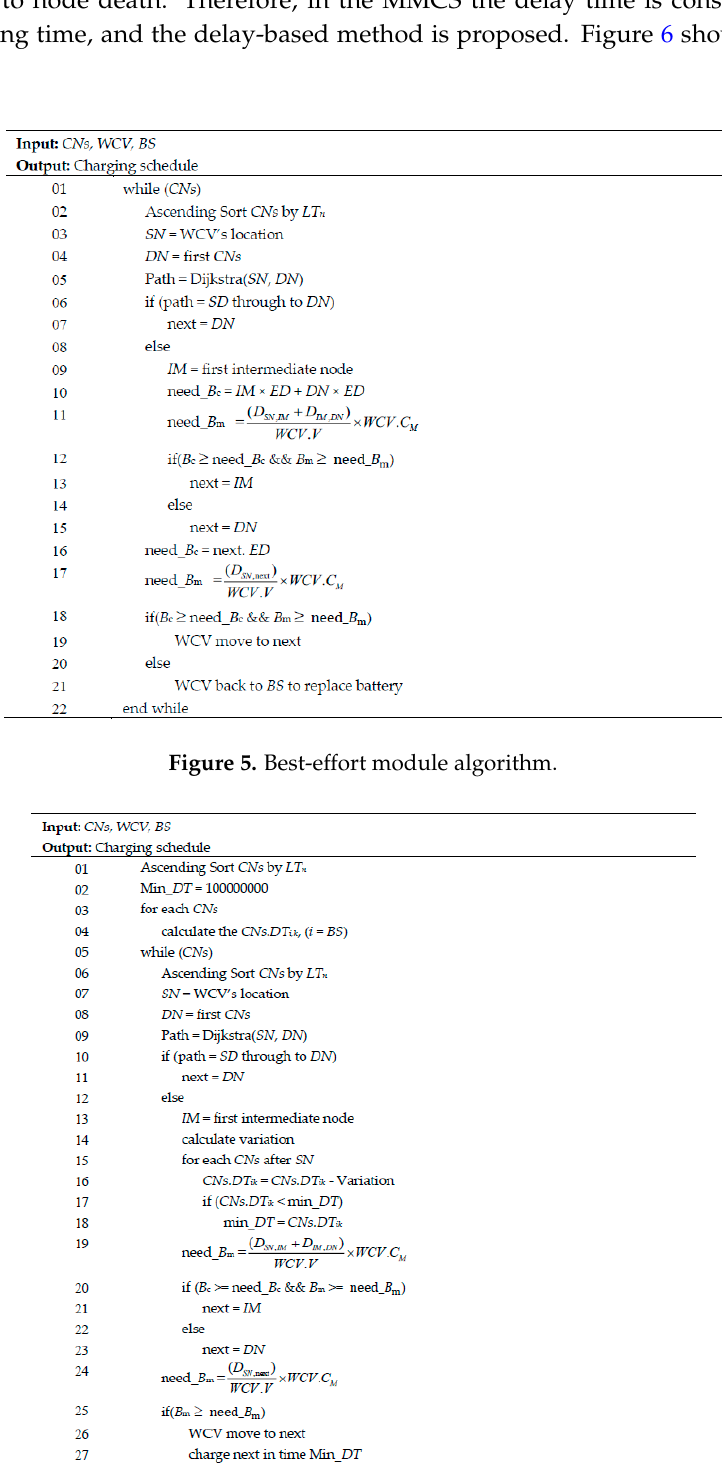
Figure 6. Delay ‐ based module algorithm.